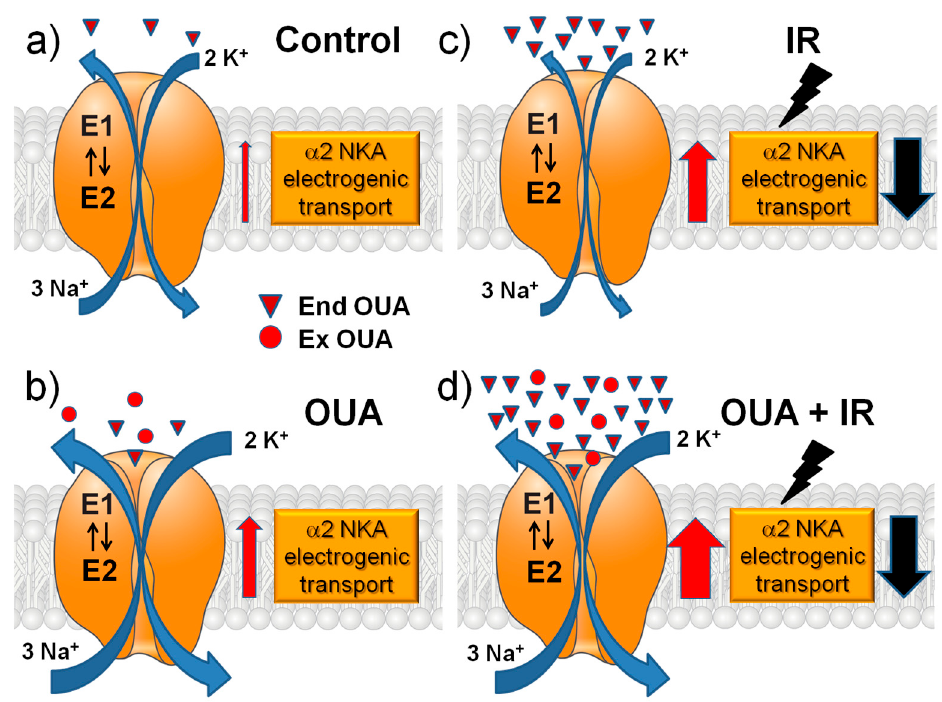
Figure 7. A schematic presentation of the main interventions in this study and their modulatory effects on the α 2 Na,K-ATPase electrogenic transport. The role of changes in sodium membrane conductance is discussed (see the text). The effects of chronic ouabain (OUA) administration, ionizing radiation (IR), or their combination (OUA + IR) in the rat diaphragm muscle were studied. ( a ) Control group: relatively low concentration of endogenous ouabain (triangles, End OUA). ( b ) Chronic administration of exogenous ouabain (circles, Ex OUA) doubles the concentration of ouabain in circulation. ( c ) IR itself greatly increases the concentration of endogenous ouabain. ( d ) Dramatic elevation of ouabain concentration under chronic administration of exogenous ouabain followed by IR intervention. Red and black arrows show the increase and decrease in the α 2 Na,K-ATPase electrogenic transport,